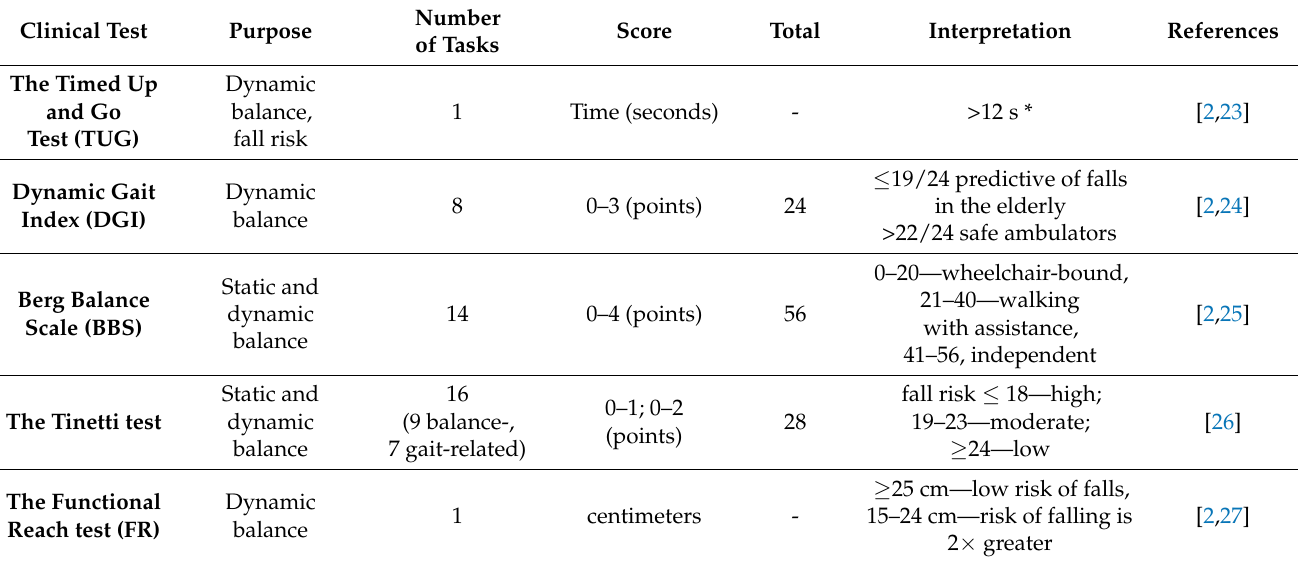
Table 1. Clinical balance